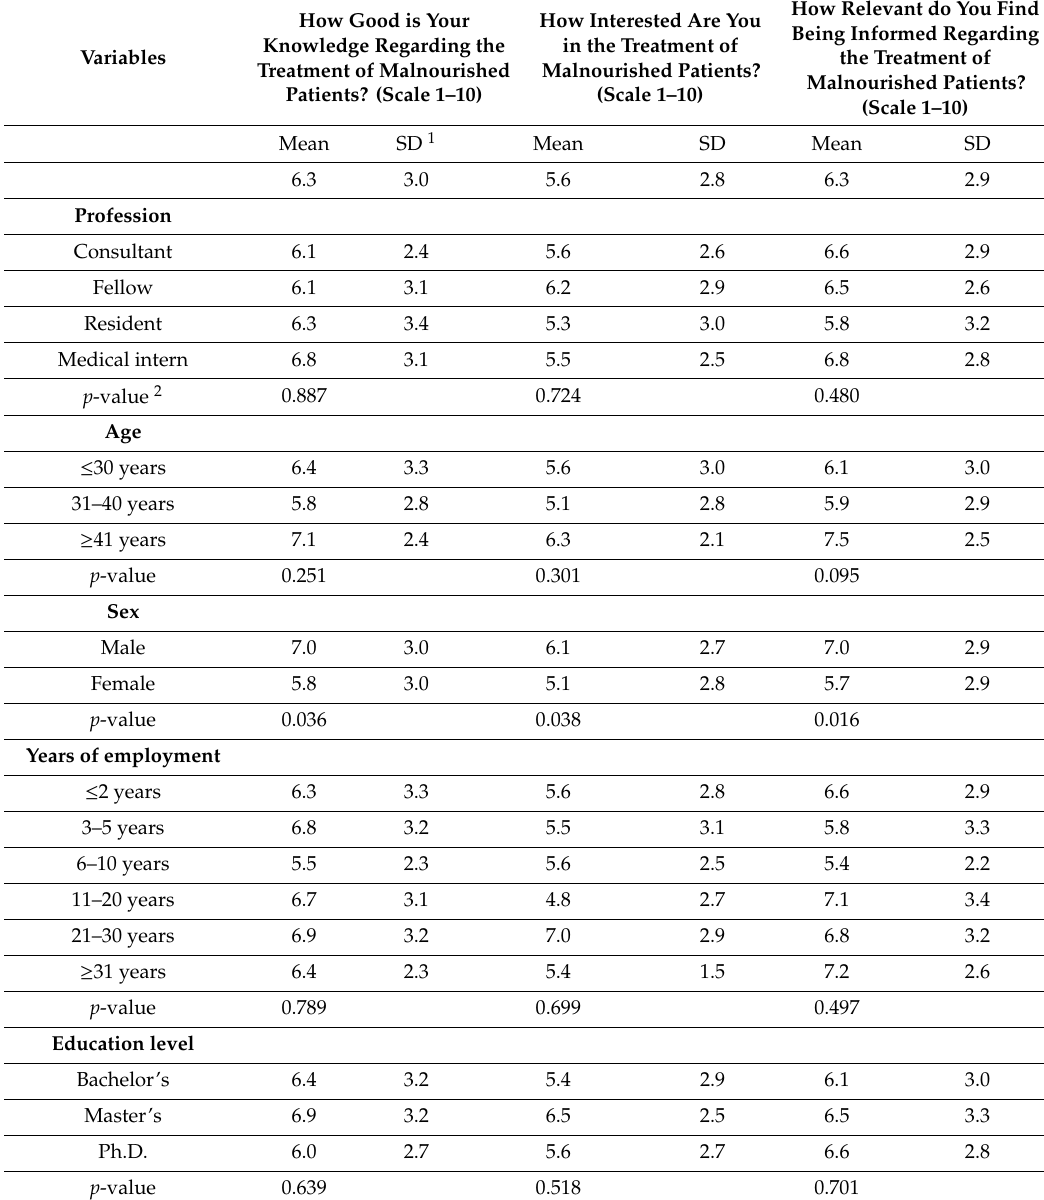
Table 5. Association between knowledge, interest, and relevance of nutritional practice and main study